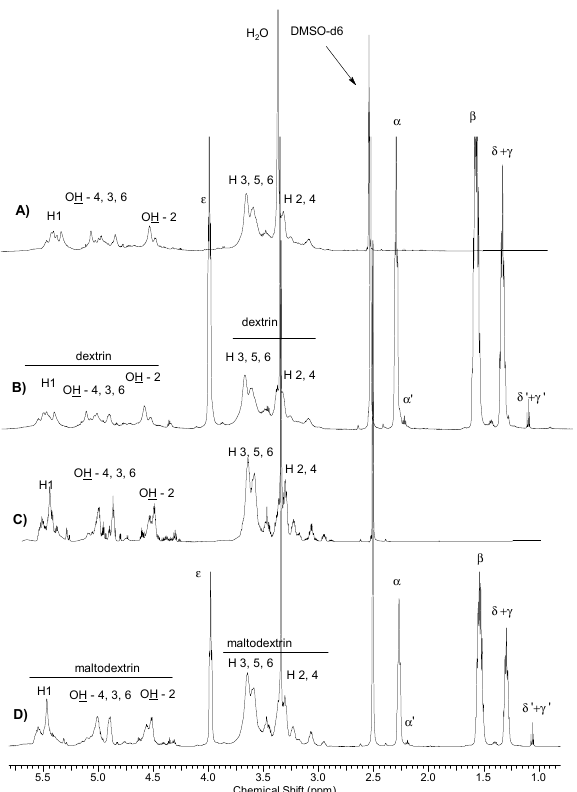
Figure 1. 1H NMR spectra of: ( A ) dextrin, ( B ) dextrin-g-PCL with weight fraction of dextrin—31 wt %, ( C ) maltodextrin, and ( D ) maltodextrin-g-PCL with weight fraction of maltodextrin—38 wt %.